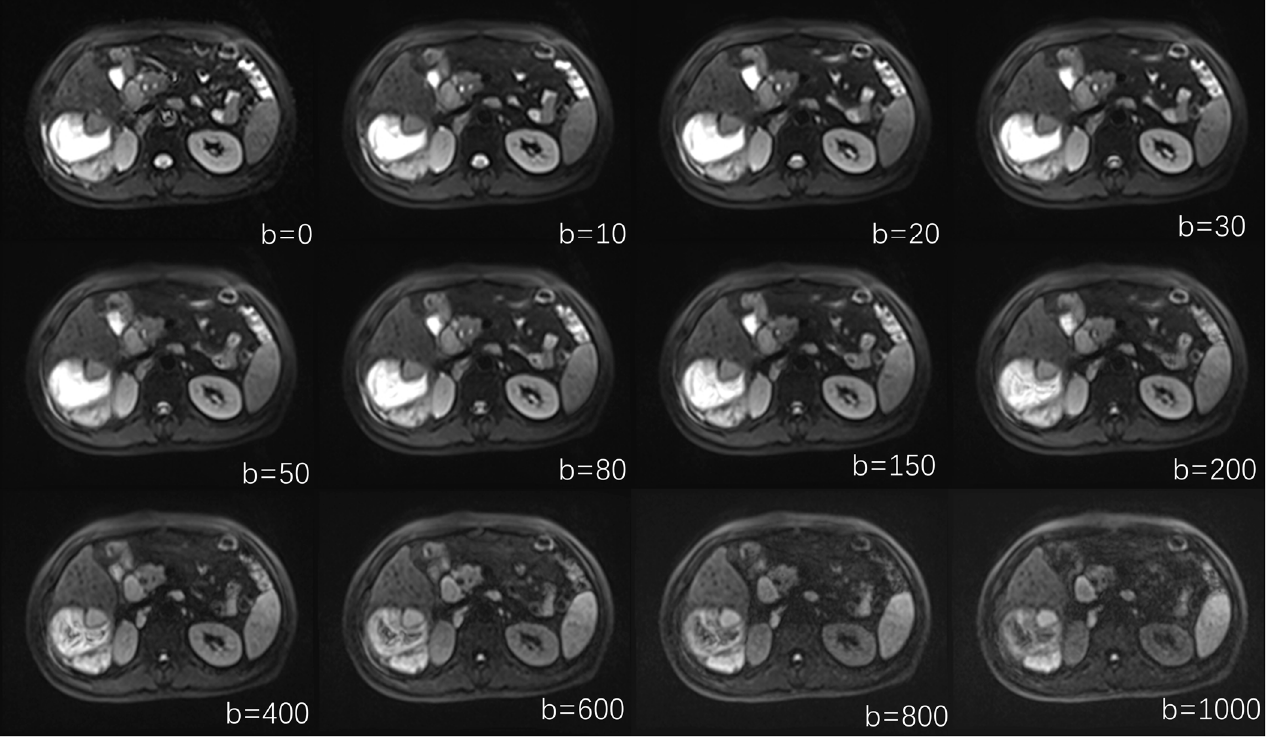
Figure 3. IVIM images at different b values. IVIM ‐ DWI images with 12 b ‐ values, representing b values of 0, 10, 20, 30, 50, 80, 150, 200, 400, 600, 800, and 1000 s/mm 2 .